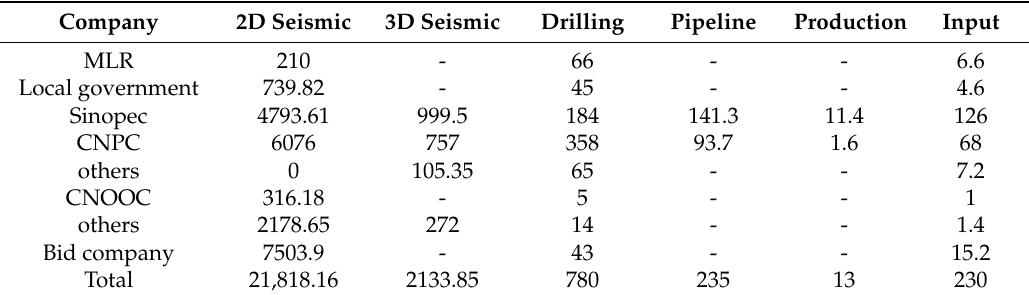
Table 2. Shale gas’s exploration and investment in China in